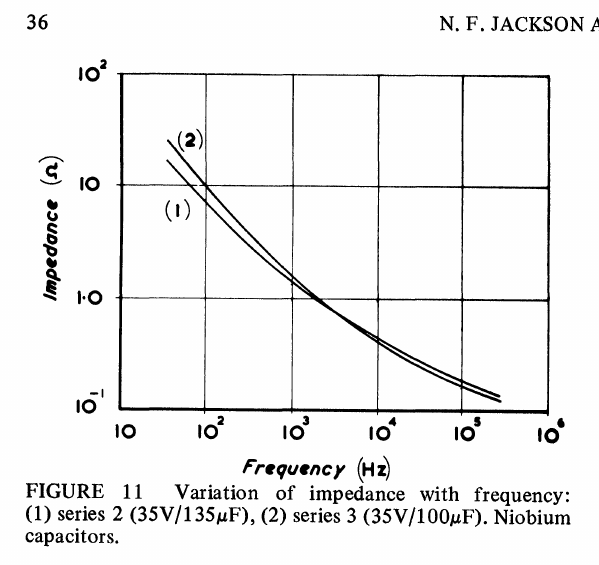
FIGURE 11 Variation of impedance with frequency" (1) series 2 (35V/135F), (2) series 3 (35V/100F). Niobium